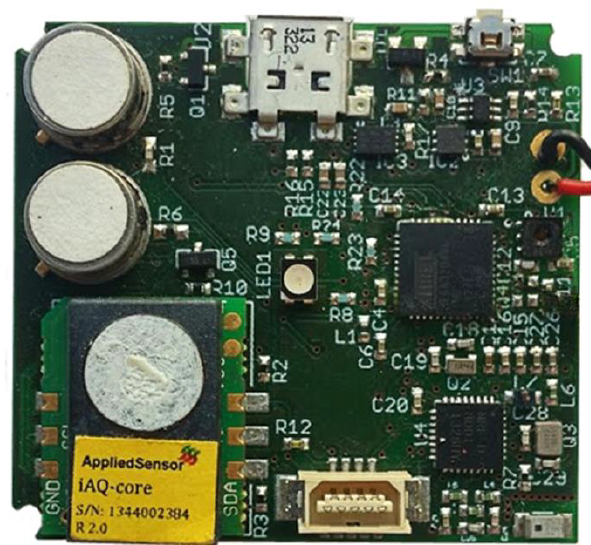
Figure 3. Final sensing unit PCB